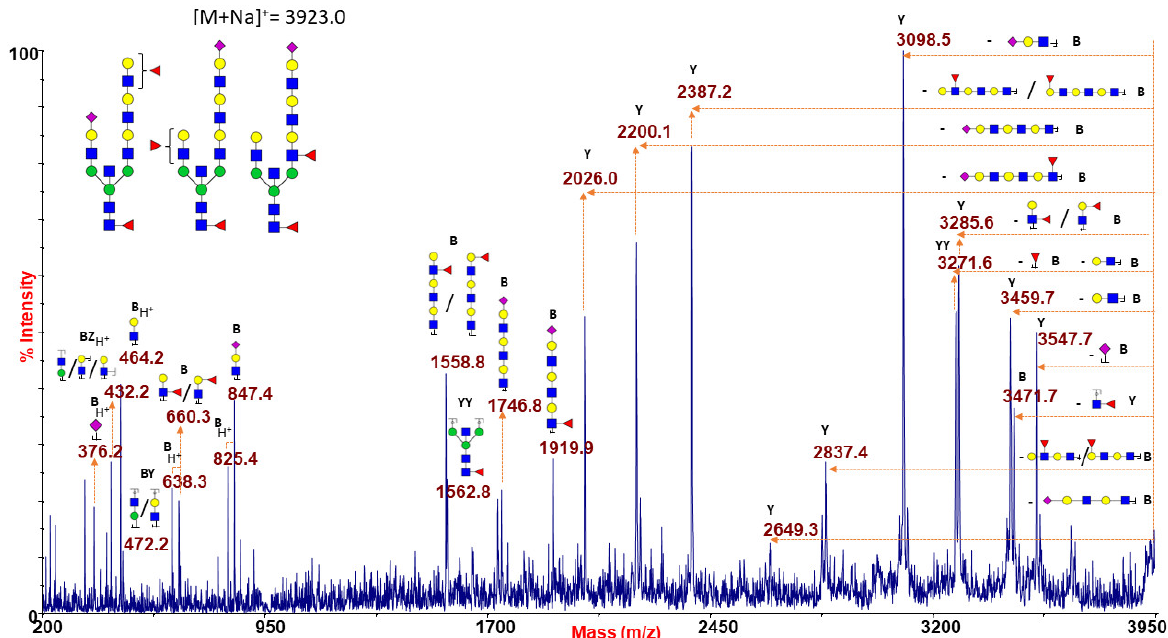
Figure 5. MALDI TOF/TOF MS/MS analysis of the N-glycan precursor at m/z 3923.0 from blood group O human erythrocytes. This fragmentation spectrum shows B and Y ion series revealing the co-presence of different isoforms characterized by mono- to tri-LAcNAc extensions which may be terminated with NeuAc or H antigen/Lewis epitopes. GlcNAc, blue square; Man, green circle; Gal, yellow circle; NeuAc, purple lozenge; Fuc, red triangle.